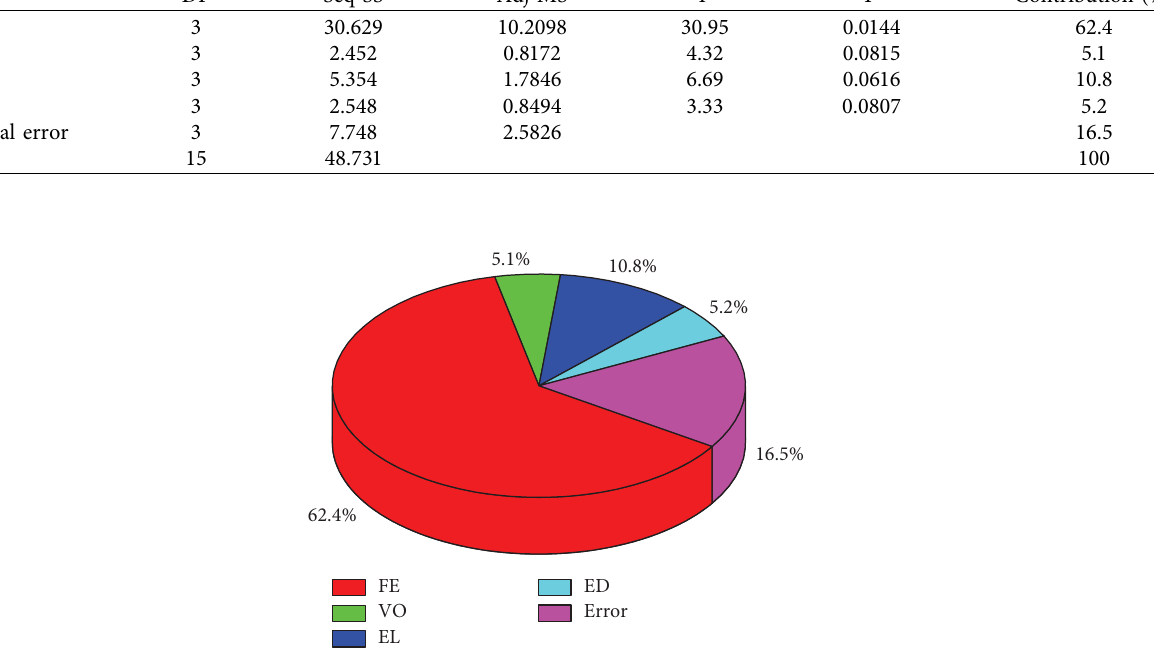
Figure 8: Parameters contribution for